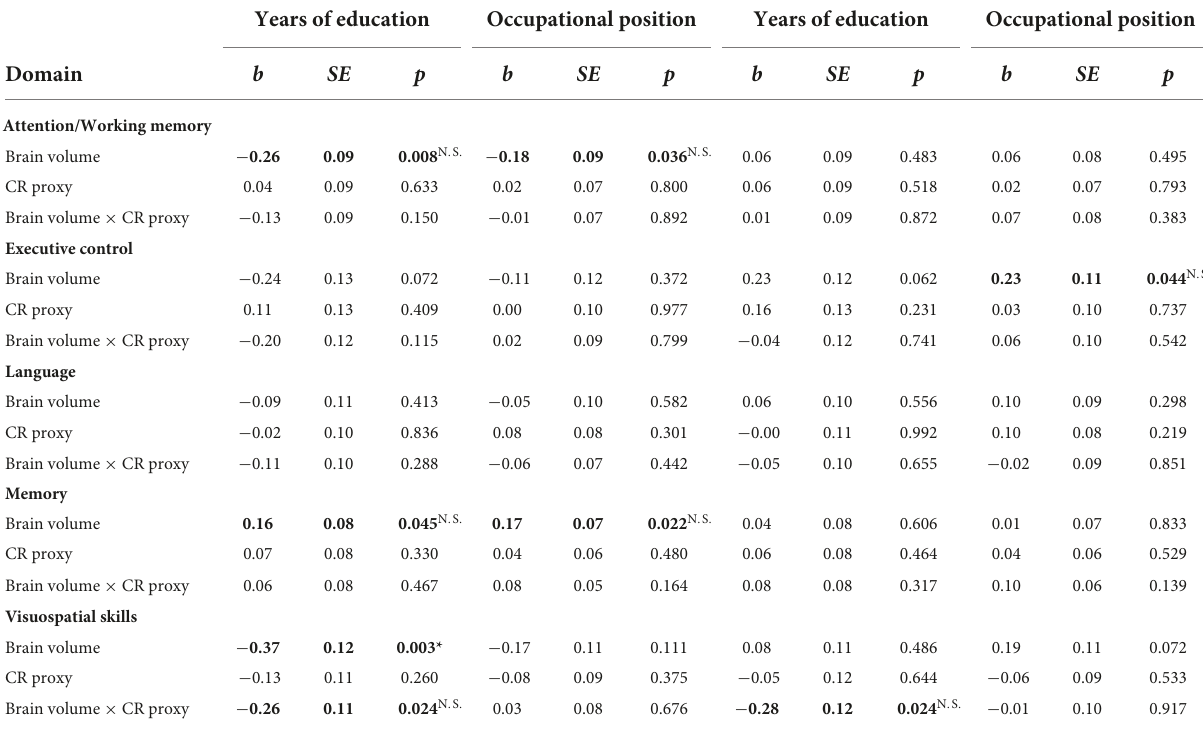
TABLE 4 Moderation analyses for participants with